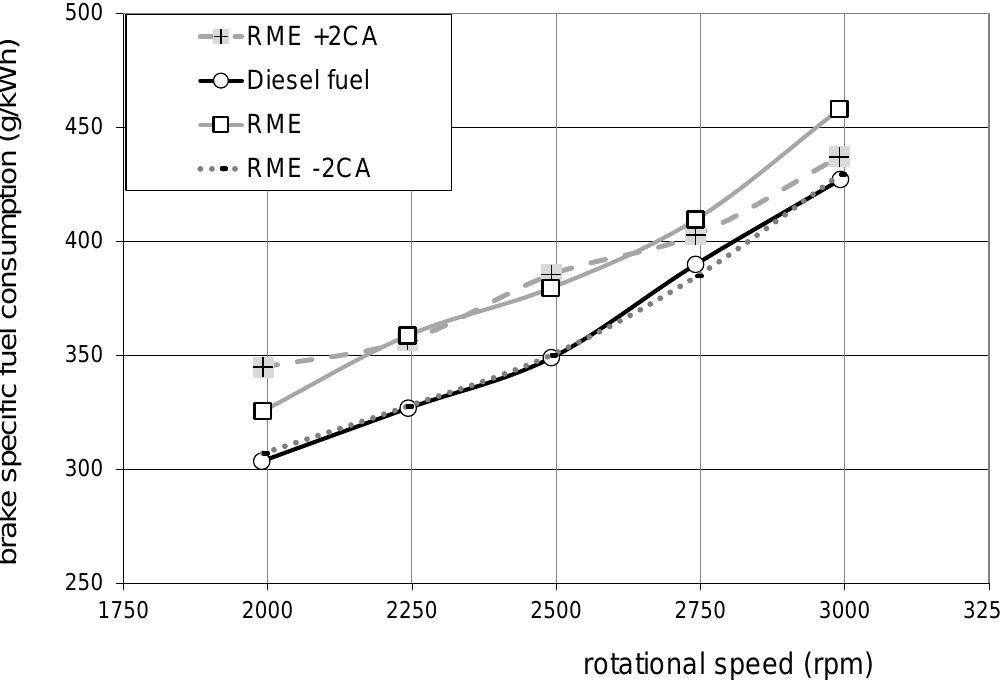
Figure 21. Brake specific fuel consumption as a function of the rotational speed at full load, for different values of the SOI and for the two tested fuels.